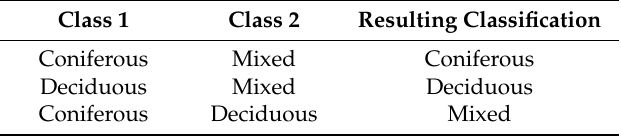
Table 2. Decision support ruleset for forest stands (image objects) classification of split decision areas. Class 1 Class